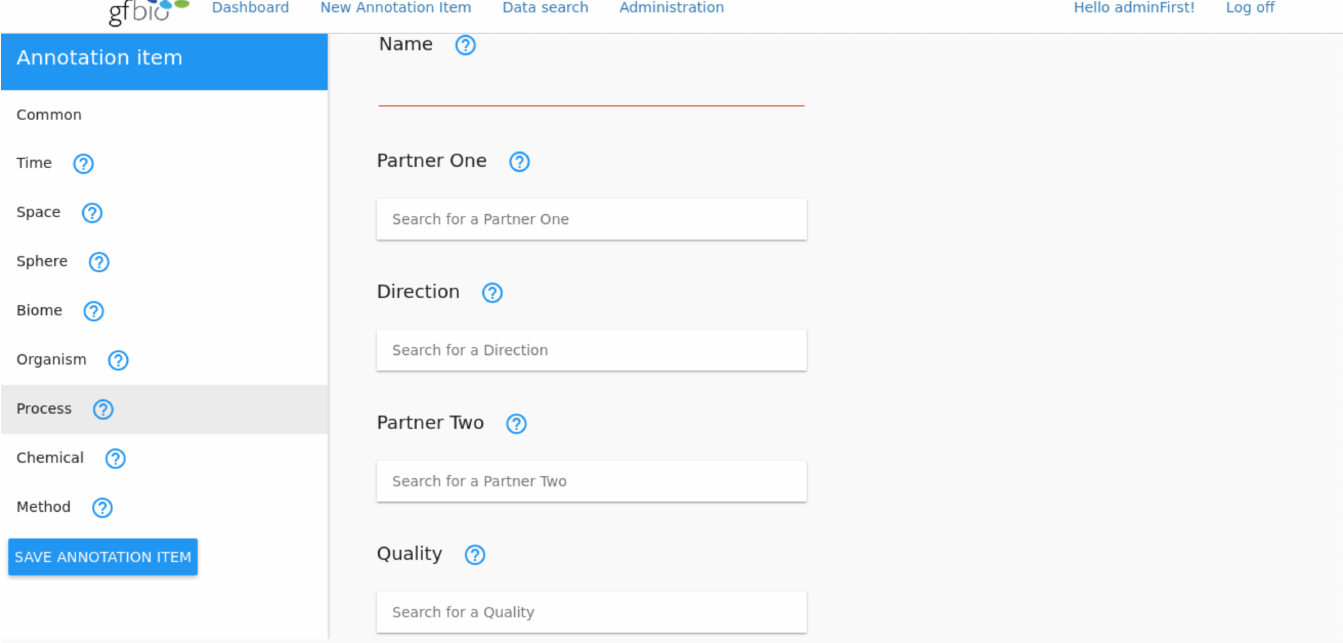
Fig 2. A mockup of a potential annotation tool which will be developed in the future based on the principles of the EASE framework. The figure here specificallydepicts the interactionpart of processes. It allows to specify the interactionname, the partners, the directionand the qualityof the interaction. For the free input fields like the name of the interaction here in this part of the annotation tool auto completionfunctionality will be provided.This allows to pick from suggestions duringthe annotationwhich come from the EASE vocabulary. If a user howeveris not able to find the right conceptualkeyword the vocabulary could be extendedcreatinga new term as requiredand addingit to the list of annotationterms to be reusedby others.